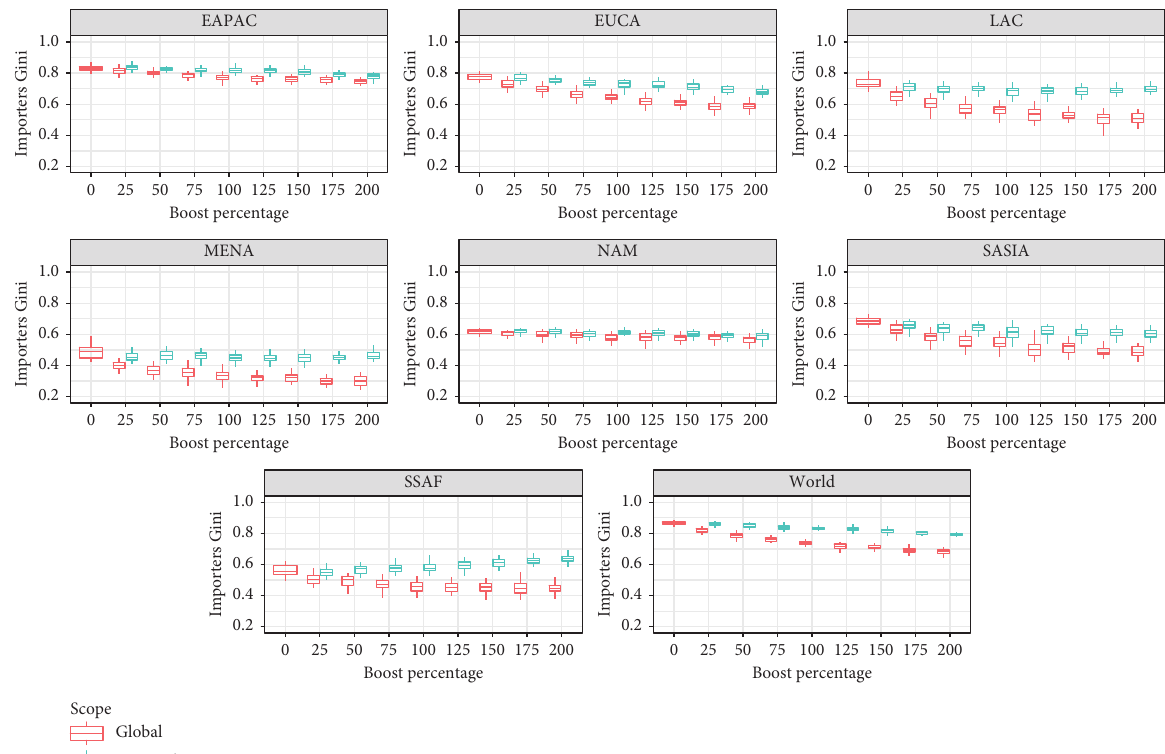
Figure 8: Effect of the improvement policies by region for year 2017. The policy is applied to the lower 2% of global trade. Each boxplot represents 30 experiments. Acronyms of the World Bank Lending Groups: EAPAC: East Asia and Pacific, EUCA: Europe and Central Asia, LAC: Latin America and the Caribbean, MENA: Middle East and North Africa, NAM: North America, SASIA: South Asia, SSAF: Sub- Saharan